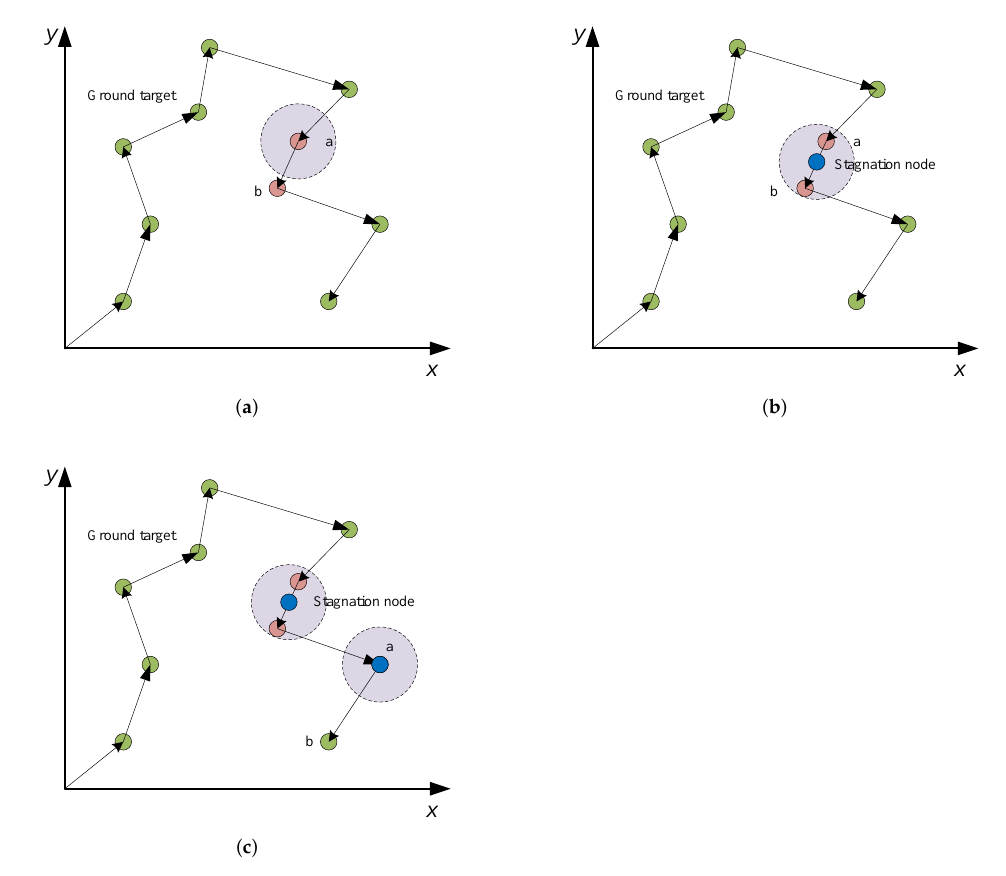
Figure 3. An illustration of the task clustering process. ( a ) A path formed by all ground targets, ( b ) A path with a stagnation node, ( c ) A path with two stagnation